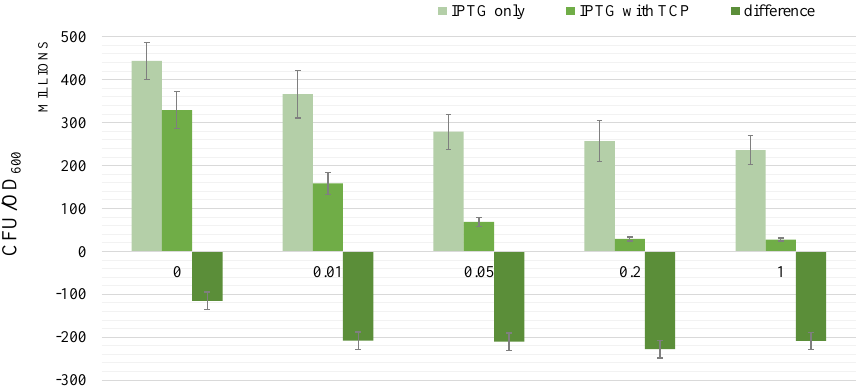
Figure 10. Exacerbation of TCP toxicity in Escherichia coli BL21(DE3) bearing synthetic TCP pathway by IPTG. The leftmost column in each dataset represents the population of cells pre-induced with various concentrations of IPTG. The middle column of each dataset shows the population of survived cells pre-induced with the same amount of IPTG after 5 h in the presence of 2 mM TCP. The rightmost column in each dataset shows the difference of the first and the second column (i.e., third = second Note that the population in the first column of the first dataset is pre-induced with 0 mM IPTG and incubated in absence of TCP, which makes it a control group. The second column in the same dataset shows the sole effect of 2 mM TCP on the population. It is remarkable that the third columns in all